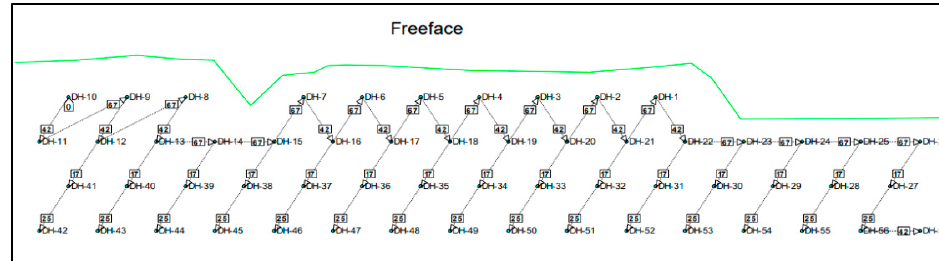
Figure 1. Blasting Round View.